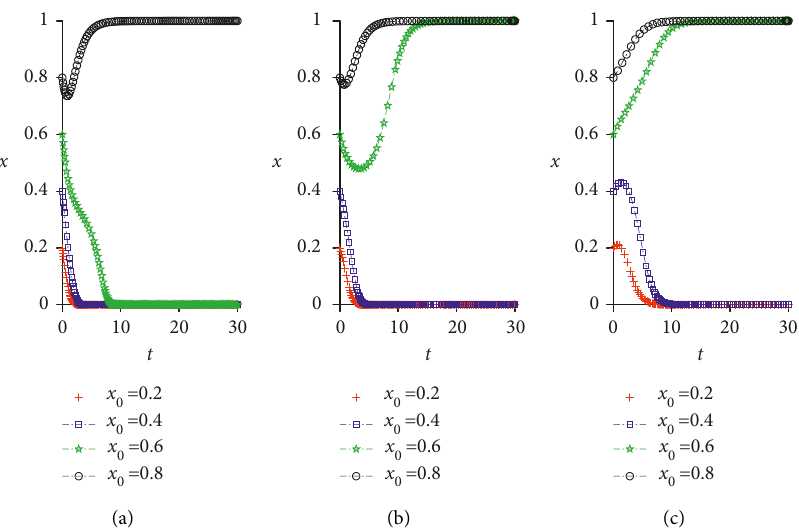
Figure 3: Impact of π on system evolution. Comparing (a), (b), and (c), as π c c dependently) increases, the probability of the system evolving to the ideal state increases. (a) π c ′